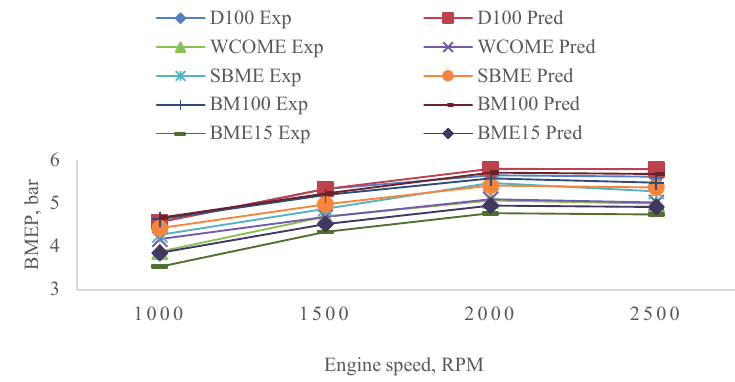
Fig. 5. Variation of brake mean effective pressure with engine